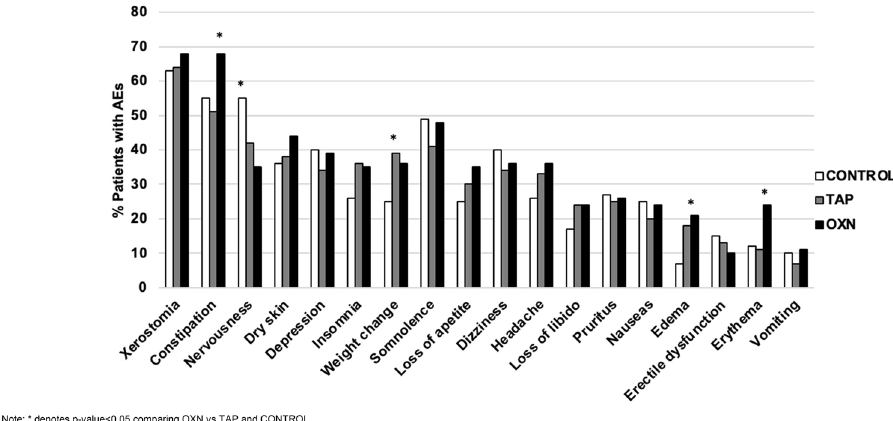
Figure 2. Percentage of patients with adverse events of patients (AEs) self-reported in in total population, control, tapentadol (TAP) and oxycodone/naloxone (OXN) cases